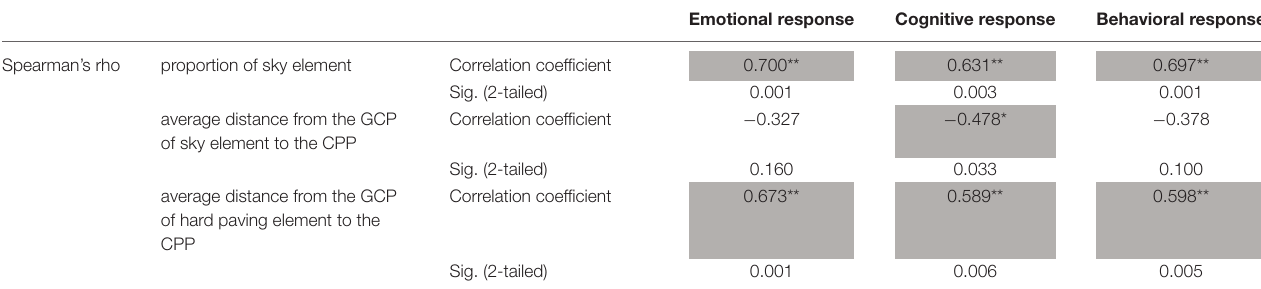
TABLE 11 | Correlations coefficient between the proportion and location of space elements and the score of self-rating restoration scale.